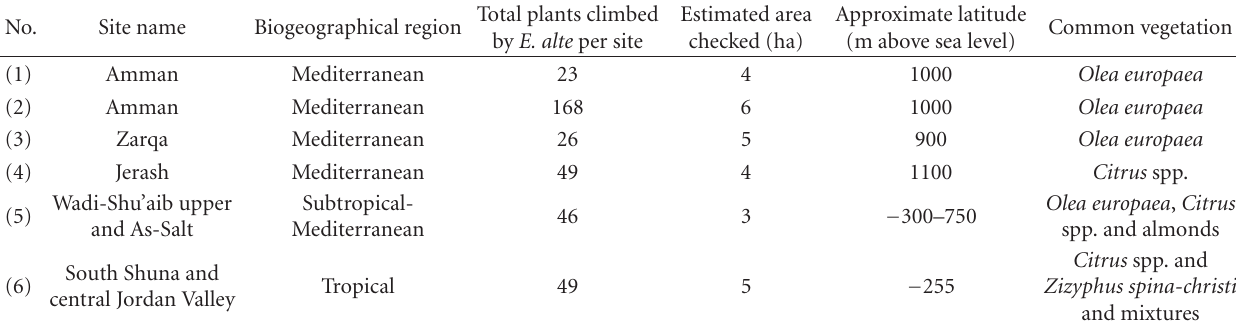
Table 1: Representative sites description and plant number attacked by E. alte late in 2010